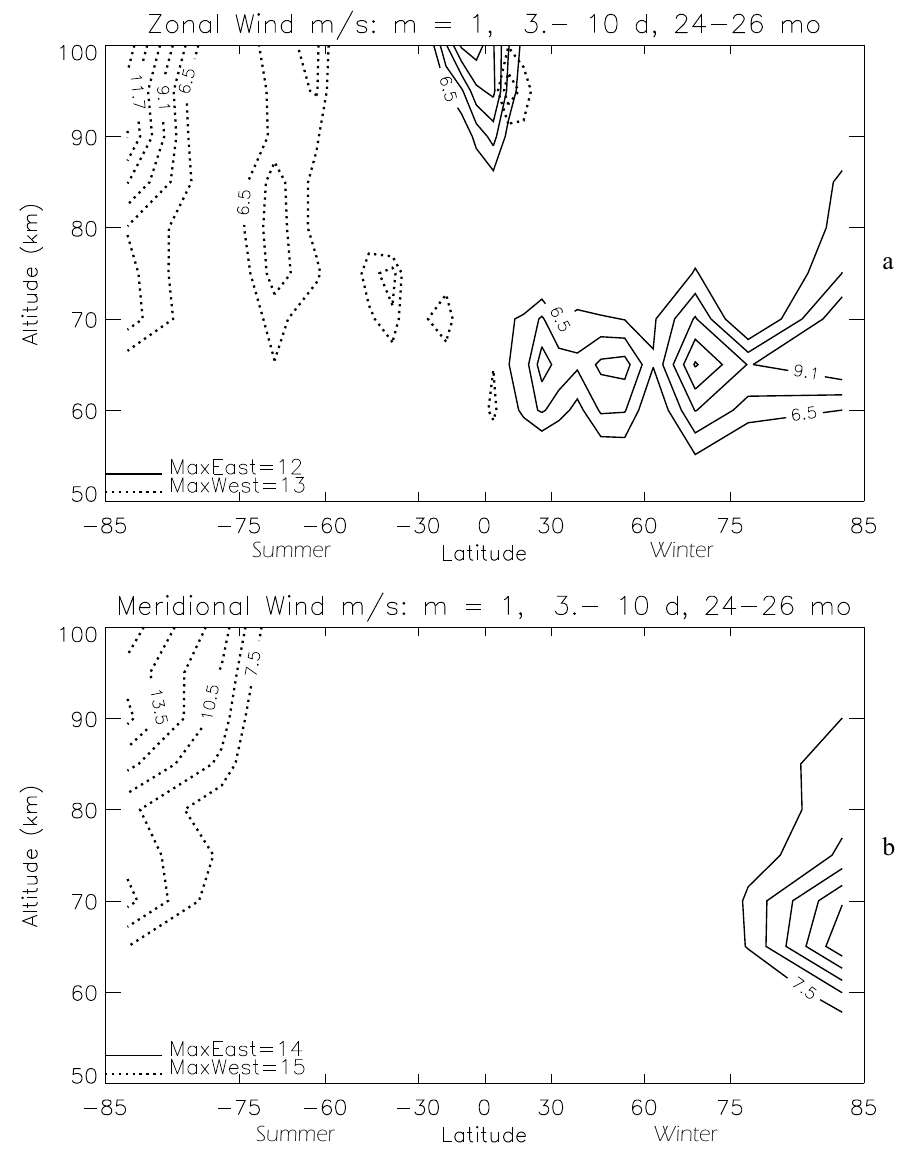
Fig. 13. Height variations of m=1 PWs with periods between 3 and 10 days. At mid to high latitudes, Rossby type PWs are present. Above 80km, Kelvin waves appear in the zonal winds. The Mercator projection is again